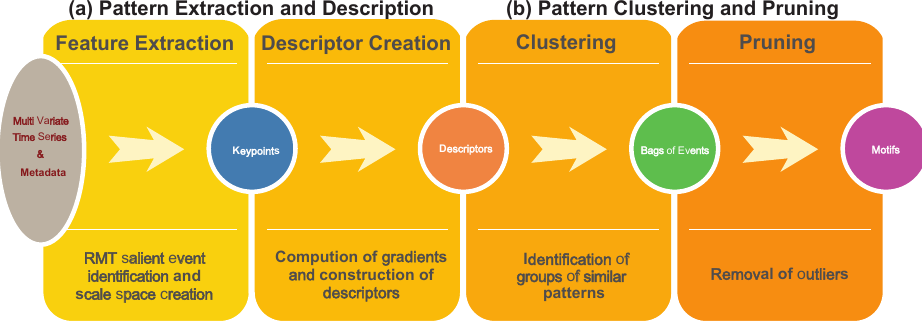
Figure 5. Overview of the SMM for contextually salient multi-variate motif